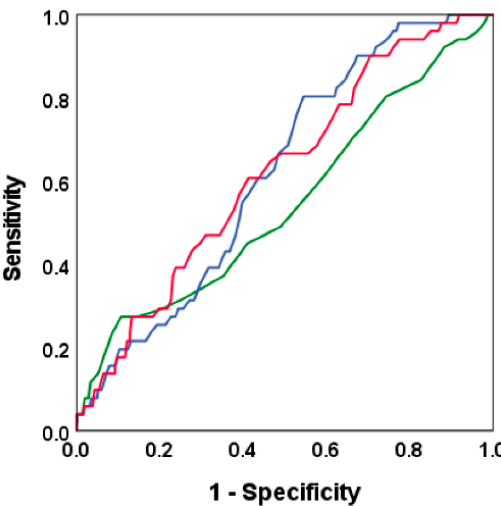
Figure 1. Receiver Operating Characteristic (ROC) curves illustrate the ability of fasting plasma glucose (FPG), 1 h post-load glucose (1 h PG) and 2 h post-load glucose (2 h PG) to detect albuminuria. The green curve indicates FPG (area under the curve (AUC) 0.55; 95% CI 0.46–0.64), blue 1 h PG (AUC 0.62; 95% CI 0.55–0.69), and red 2 h PG (AUC 0.62; 95% CI 0.54–0.70) levels.